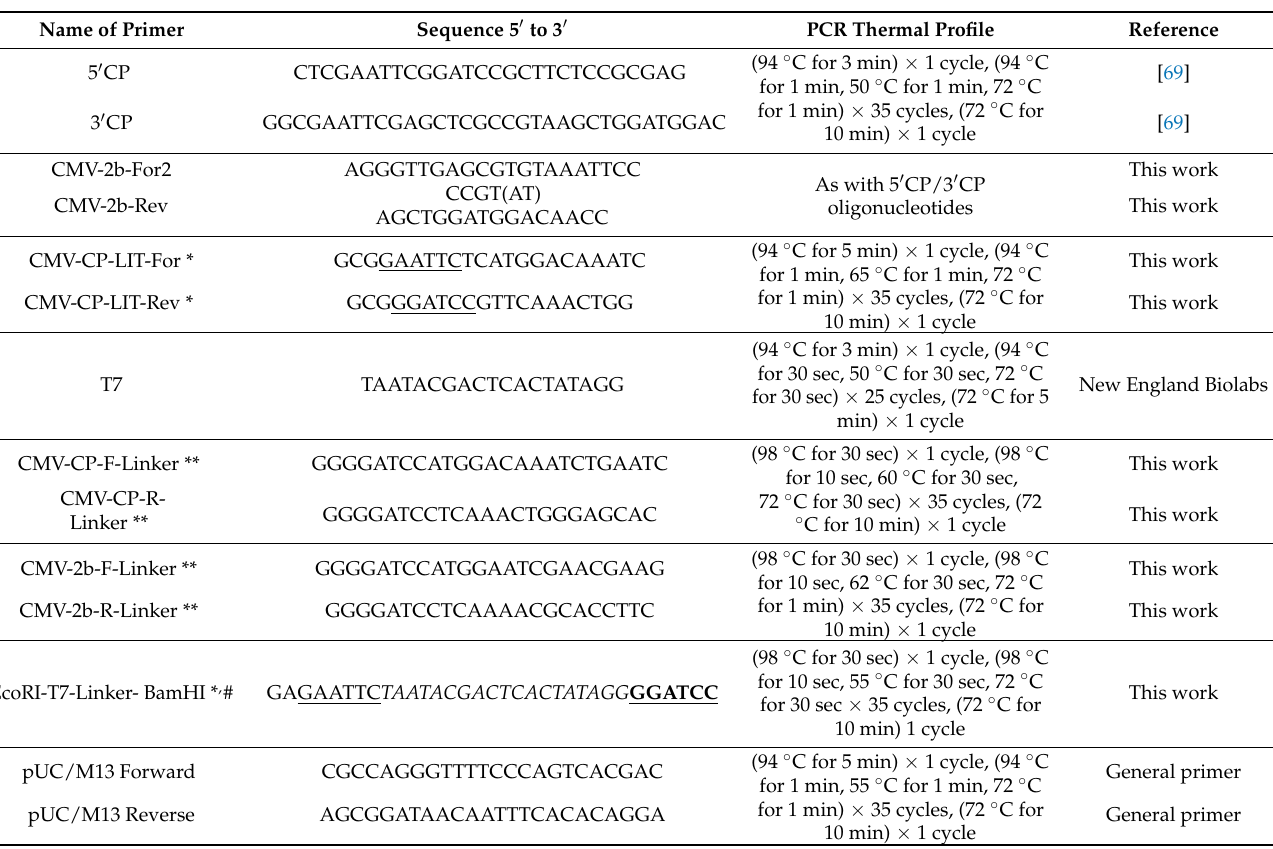
Table 1. Primers and PCR conditions used in this